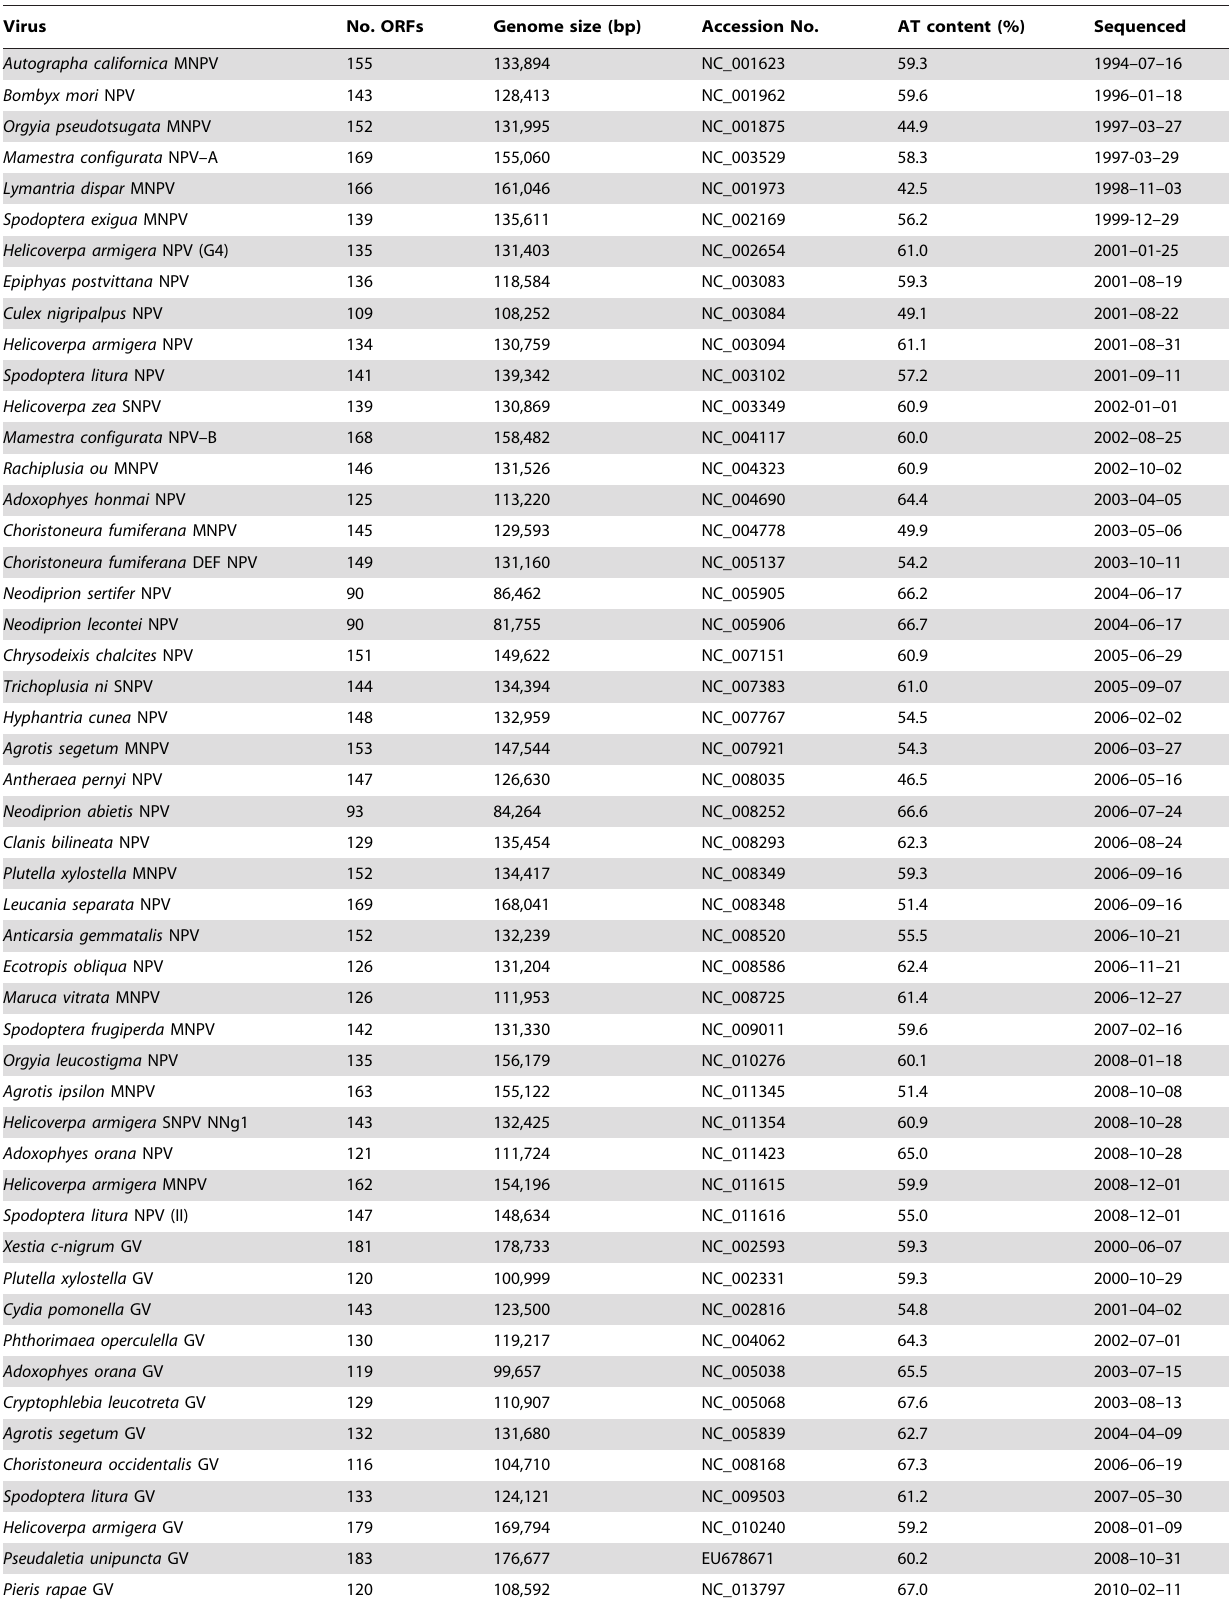
Table 1. Characteristics of baculovirus genomes (February